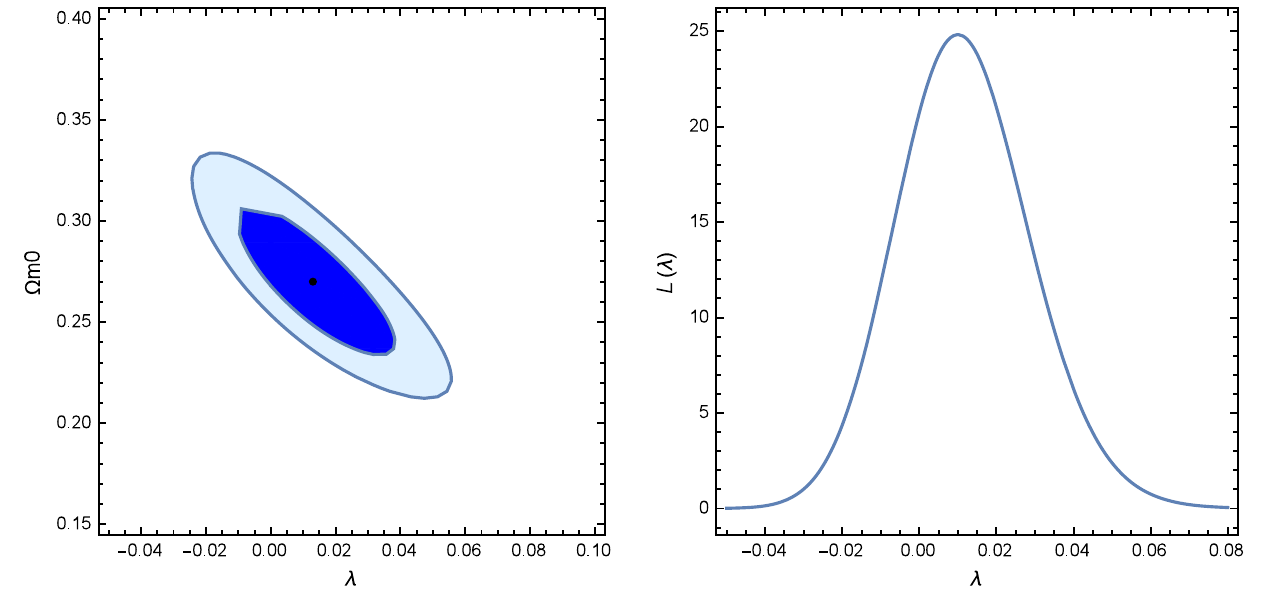
Fig. 2 Thefigureontheleftshowsobservationalconstraintsonparam- eters (λ,(cid:2) m 0 ) withthecombinationofSNIaandBAO/CMBdatasets,in whichthelightblueandblueregioncorrespondtothe2 σ and1 σ region, respectively, while the black point (0.013,0.269) with χ 2 = 564 . 811